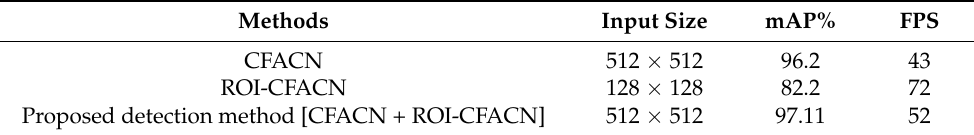
Table 5. Overall detection accuracy and frames per second (FPS) results of the proposed methods without tracking algorithm.